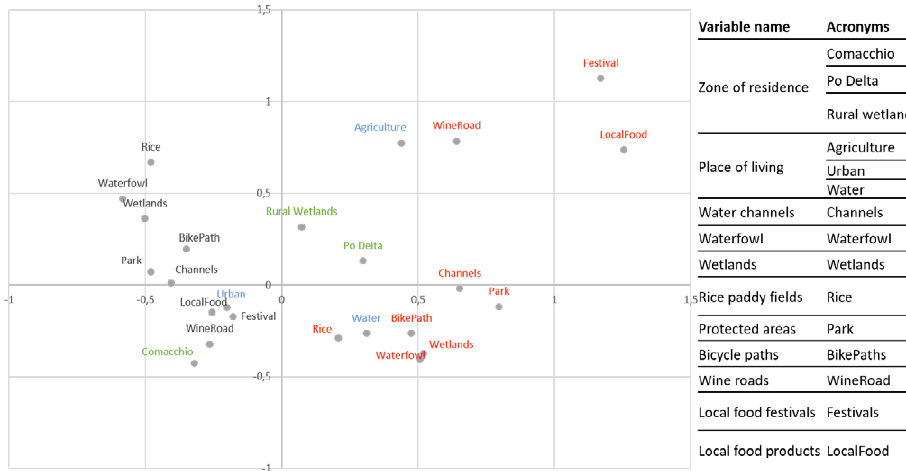
Figure 2. biplot of the multiple correspondence analysis showing the relation between residents’ per- ception of benefits from the landscape elements and the variables “place of living” and “zone of resi- dence”. Landscape variable categories identifying a heterogenous perception are reported in red; cate- gories linked to homogenous perception are reported in black. In blue are reported the categories for the variable “place of living” (close to agricultural areas, water-related elements, urbanized area) and in green the categories for the variable “zone of residence” (Comacchio, rural wetlands, Po Delta). Cfr. to table 3 for the acronyms of the variable